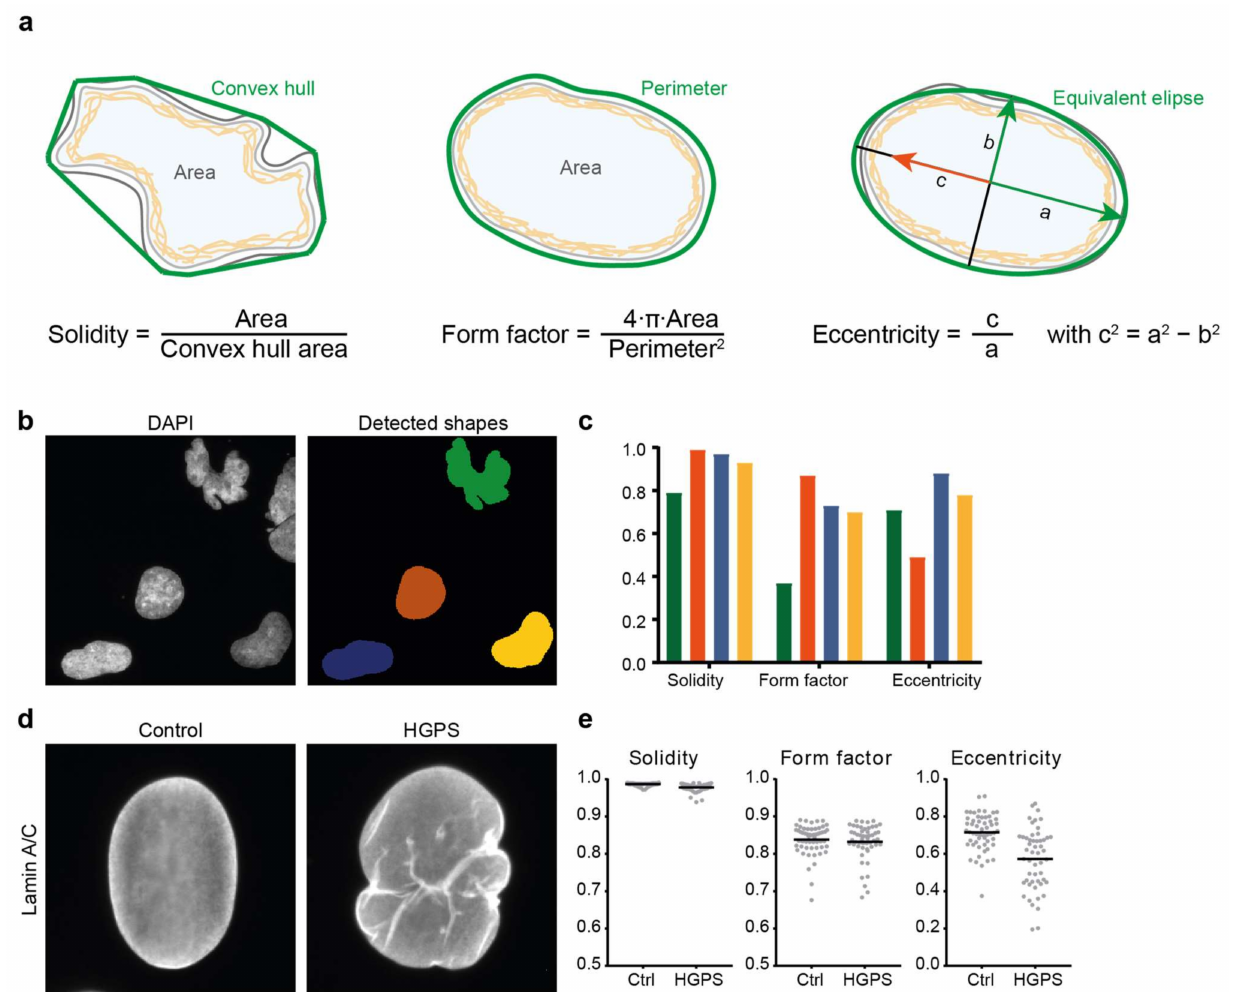
Figure 2. Commonly used parameters to describe nuclear shape. ( a ) Visual representation and mathematical definition of 3 routinely used nuclear shape descriptors: solidity, form factor (or circularity) and eccentricity. Values for each of these range from 0 to 1. ( b , c ) Example of nuclear shape analysis on DAPI-stained nuclei in fibroblasts derived from a patient with Nestor-Guillermo progeria syndrome (NGPS). Nuclear shapes in ( b ) were detected in CellProfiler; ( c ) Comparison of the values of three nuclear shape descriptors for the four detected nuclei shown in ( b ), with the colours of the bars corresponding to the colours of the nuclear masks in ( b ). Elongated shapes are better distinguished from rounder shapes by eccentricity than by solidity, while the highly lobulated nuclear shape is well distinguished using solidity and form factor. ( d ) Lamin A/C staining of a representative nucleus in a healthy donor fibroblast and a nucleus in a fibroblast from a patient with HGPS. The HGPS nucleus shows lamin invaginations, absent in the control nucleus, and a bulged nuclear contour. ( e ) Analysis of >50 nuclei in control and HGPS fibroblasts of similar cell passage yields significant differences for the nuclear solidity ( p < 0.001) and eccentricity ( p = 0.0003) but not for the form factor ( p = 0.24). More elaborate nuclear shape analyses such as mean negative curvature calculation or elliptic Fourier transform (see text for details) are also able to distinguish control from HGPS